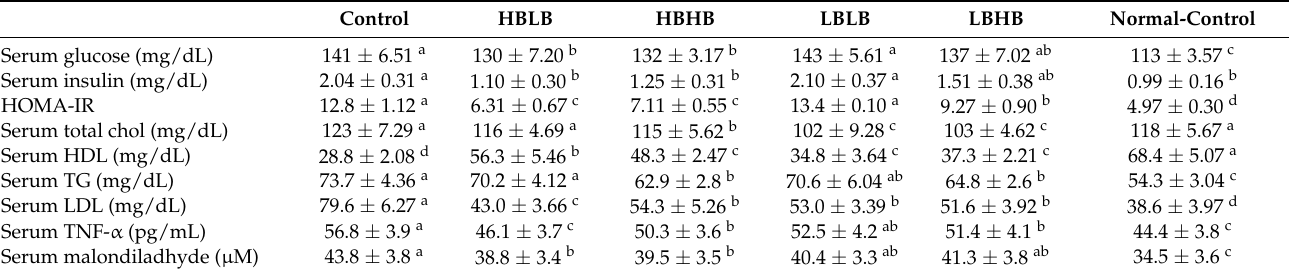
Table 3. Glucose metabolism and lipid